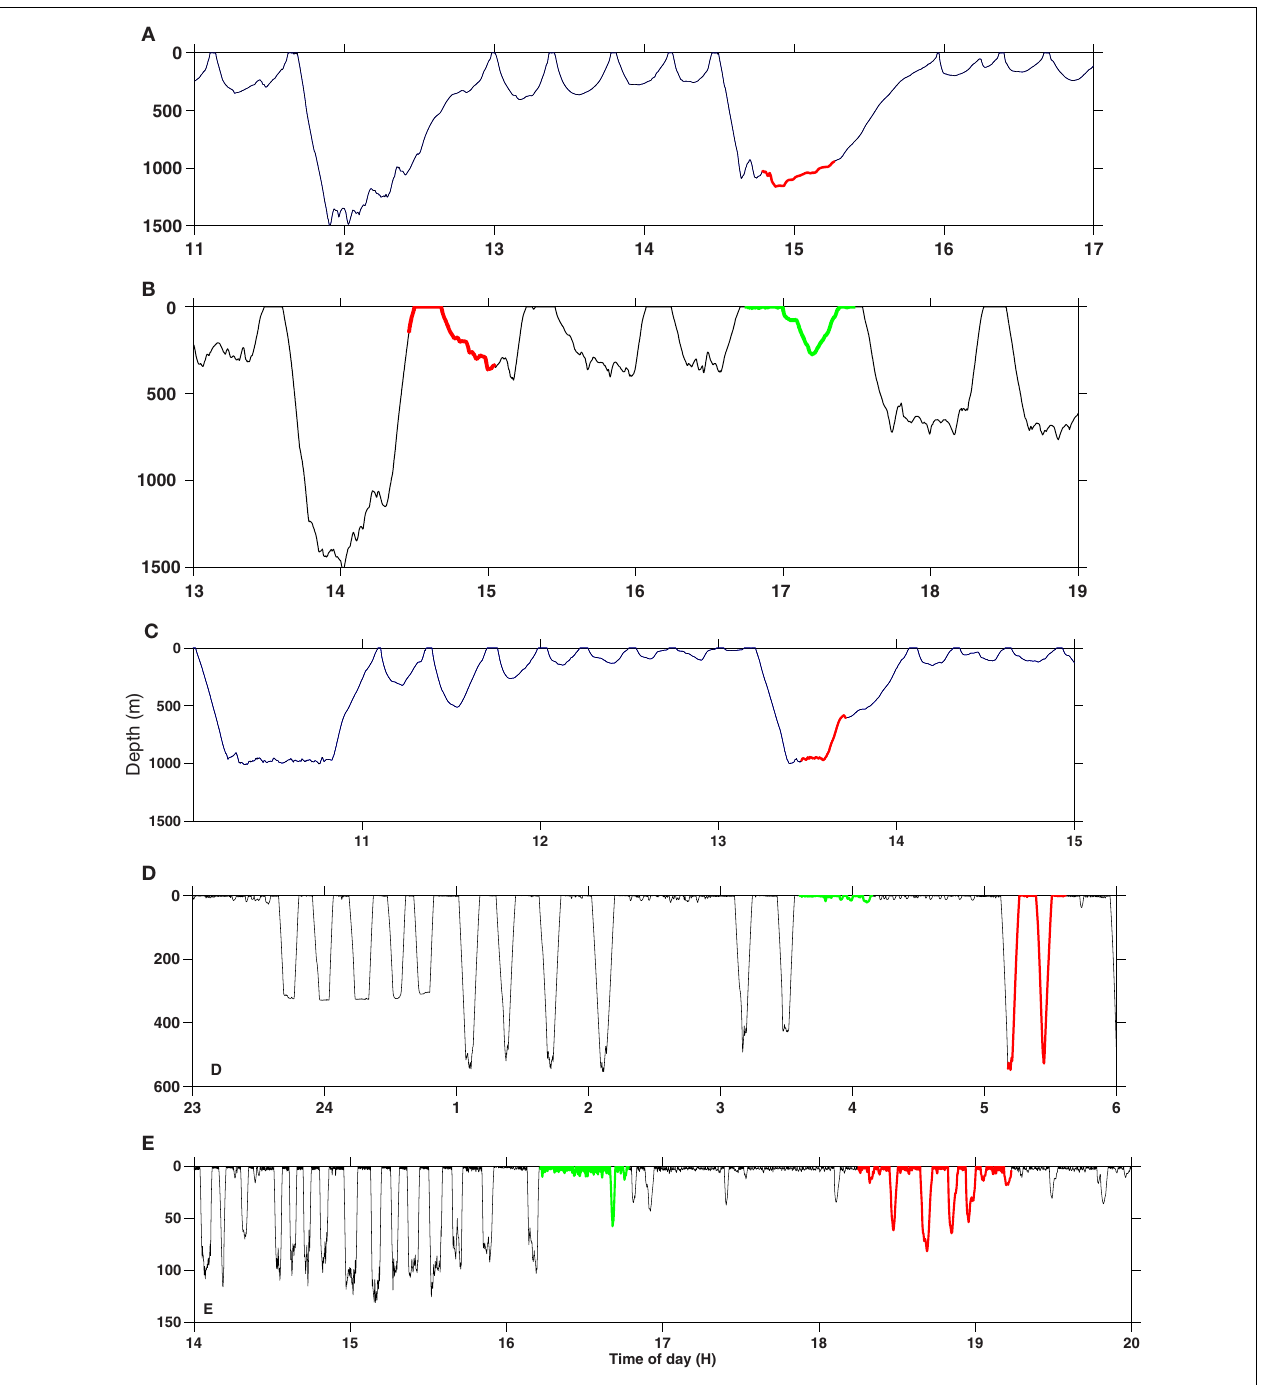
killer whale (oo09_144a).The red part of the dive profile is exposure to MFAS sonar and the green to LFAS sonar.Time is in hours GMT and depth is in meters. Note the differences in depth scale between the different